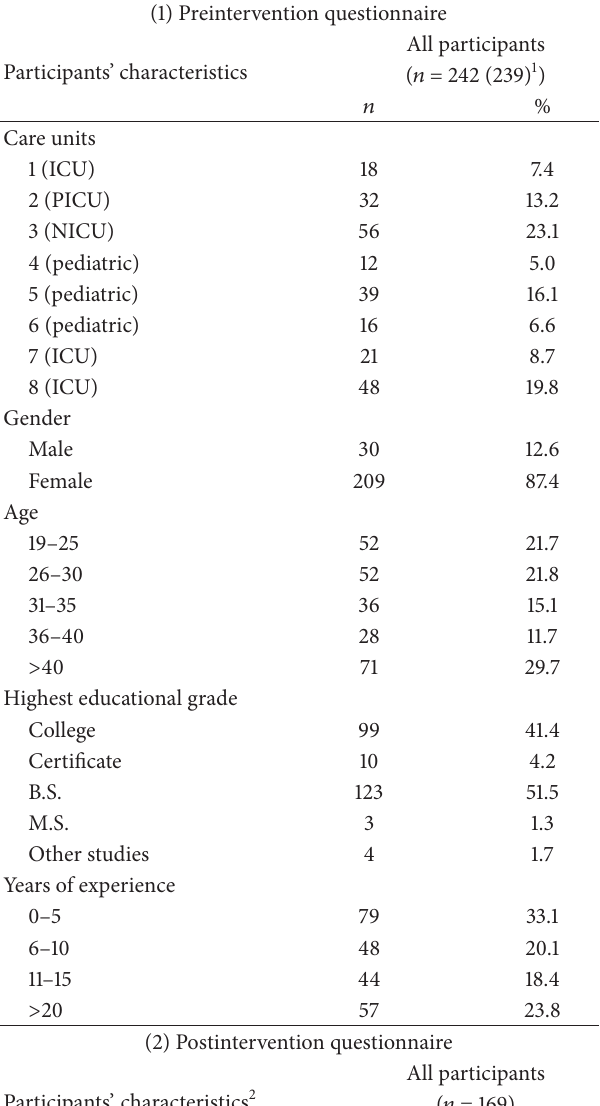
Table 2: Characteristics of the participants, before and after inter-